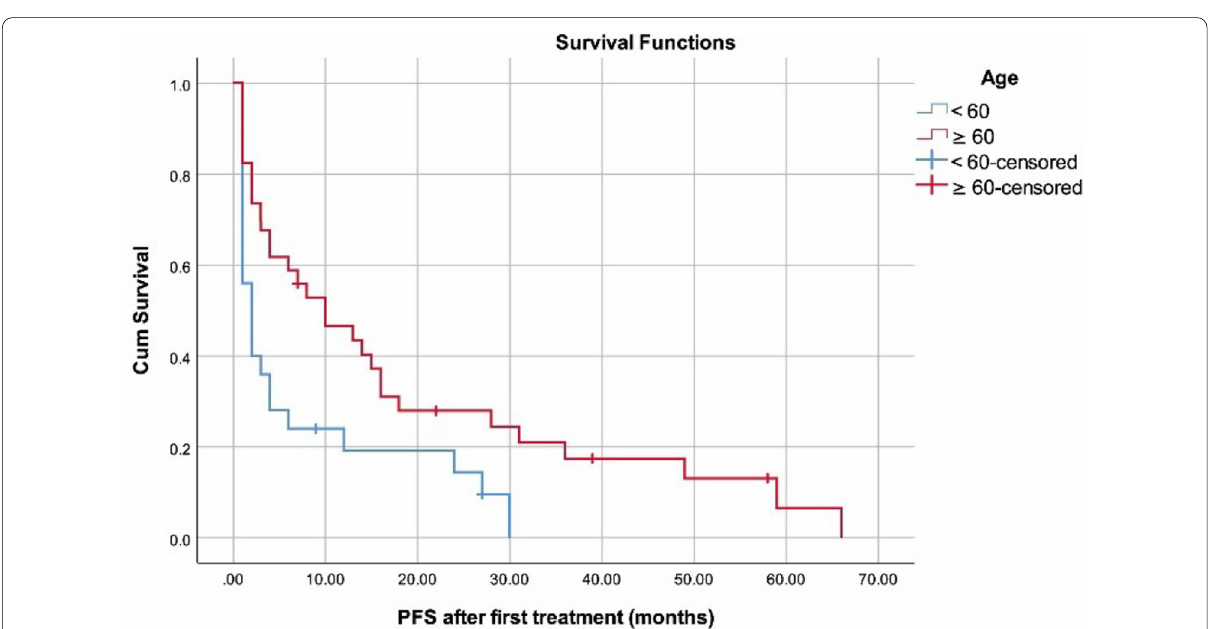
Fig. 5 Progression-free survival after first-line therapy by